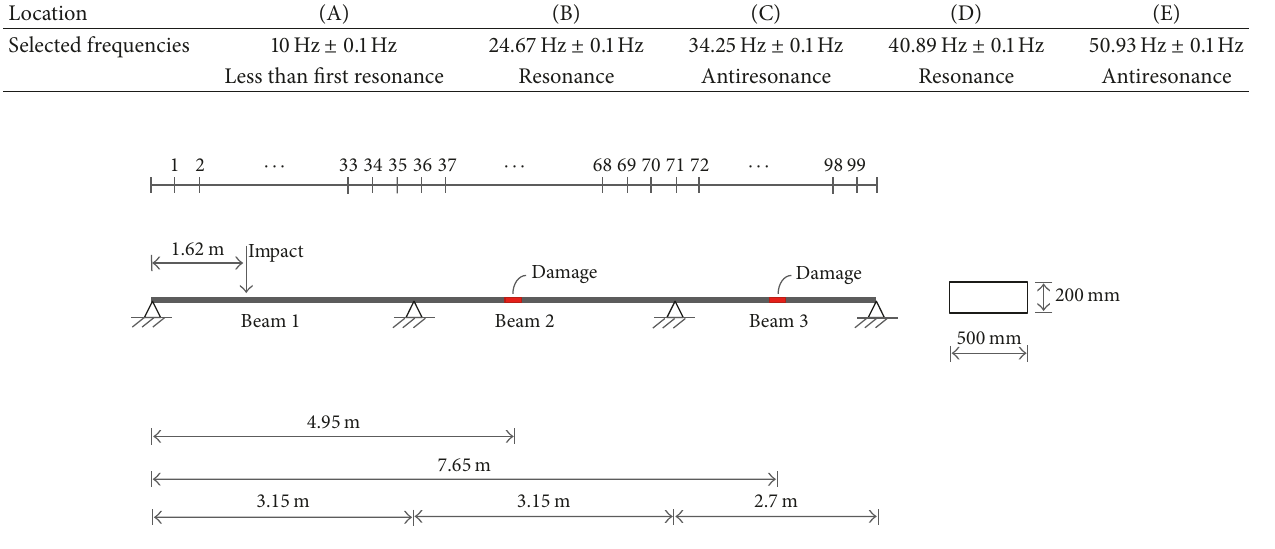
Figure 2: A three-span continuous beam structure model.